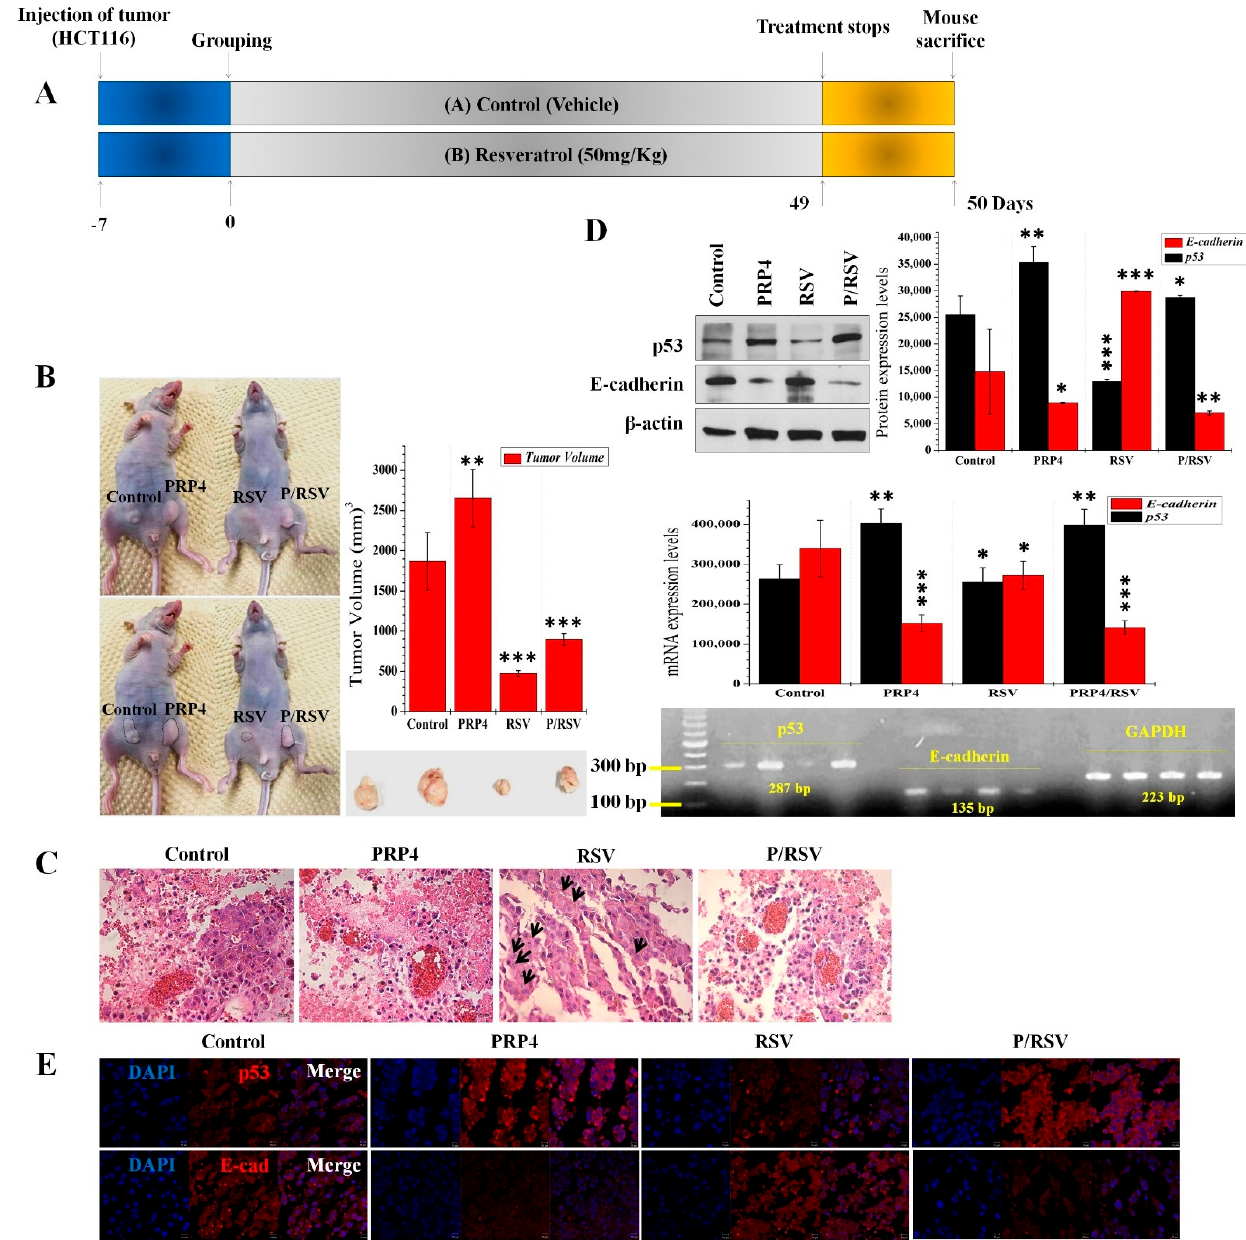
Figure 2. PRP4 promotes colon tumors in vivo: ( A ) Schematic of the in vivo experiment. BALB/c-n mice were treated with resveratrol (50 mg/kg body weight) or DMSO (vehicle) by intraperitoneal injection once daily, beginning one week and ending at six weeks after implantation of tumor cells, and mice were euthanized at Day 50; ( B ) the antitumor effects of resveratrol are blocked by PRP4 overexpression. Representative images of mice and tumors from each treatment group are as shown. BALB/c-n mice received parental HCT116 cells on the left side and PRP4-overexpressed HCT116 cells on the right side (left and right sides are according to the photo) by subcutaneous injection. Tumor volumes from individual mice are presented as mean ± standard deviation ( n = 5 per group, Student’s t -test, ** p < 0.01, *** p < 0.001). For clear visibility of the tumors in vivo, the same mouse was photographed twice; the tumors are encircled in the latter set of photographs. RSV, treatment with resveratrol; P/RSV, transfection with PRP4 followed by treatment with 10 µM resveratrol; ( C ) sections of xenotransplant tumors from control and resveratrol-treated and/or PRP4- overexpressed groups were subjected to Hematoxylin and Eosin (H&E) staining. Cell staining in-